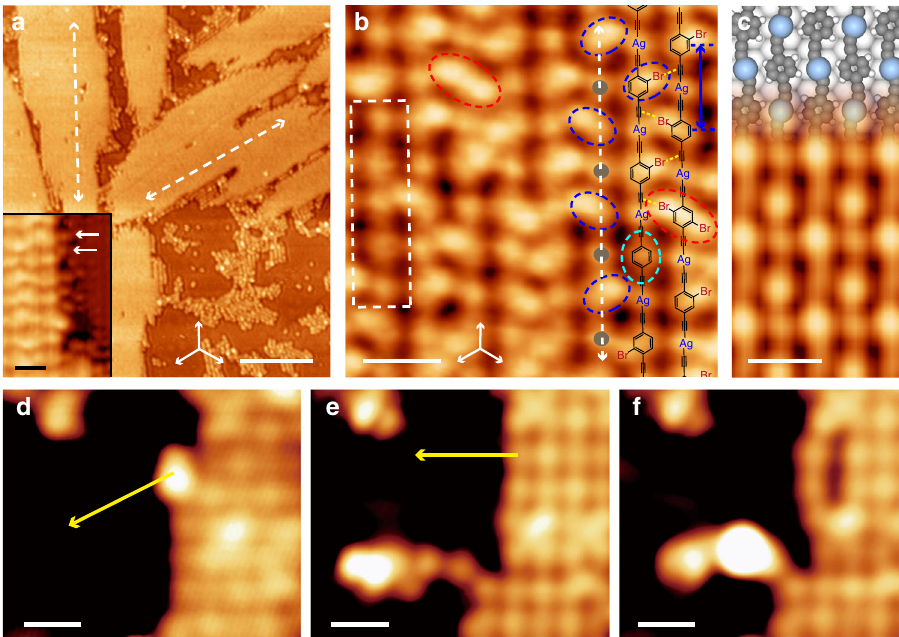
Fig. 3 1D ASA chains formed at 300 K. a STM image of stripe-shaped islands formed on Ag(111) after annealing of the sample at 300 K for 8 h (200 mV, 170pA, 77 K). Inset: STM image of the periphery of a stripe-shaped island (60 mV, 180 pA, 77 K). Some detached Br atoms are representatively marked by the white arrows. b High-resolution STM image of the ASA chains with their structural models superimposed (60 mV, 180 pA, 77 K). Molecules with two, one and zero Br atoms attached are correspondingly highlighted with the red, blue and cyan dashed circles. Ag atoms are marked by the gray dots. The interactions between adjacent chains are marked by the yellow dashed lines. The inter-molecular distance of the ASA chain is marked by the blue arrow. The chain-segment formed by completely debrominated molecules is highlighted by the white dashed rectangle. The extending directions of the islands are marked by the white dashed arrows in a and b . The equivalent < 1 (cid:1) 10 > directions of Ag(111) are marked by white arrows in a and b . c Optimized molecular models of the ASA chains (top) and correspondingly simulated STM image at 100 mV (bottom). Color code: gray: C, white (small): H, white (large): substrate Ag, blue: adatom Ag. d - f Sequential lateral tip manipulations of the ASA chains along the directions marked by yellow arrows (200 mV, 100pA, 4.2 K). Scale bars: a 20 nm, Inset: 1 nm, b , c 1 nm, d – f 2